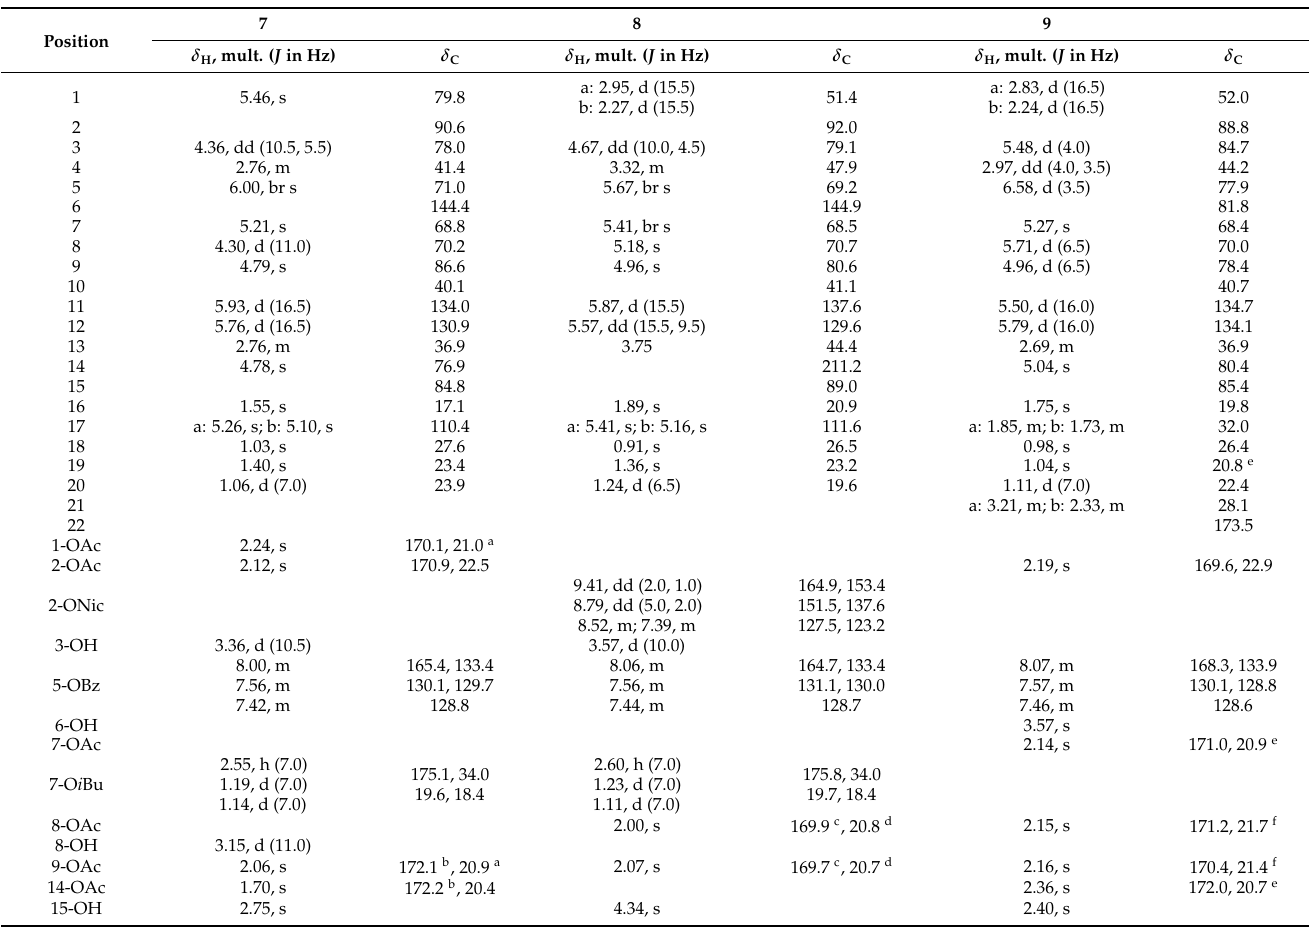
Table 3. 1 H (500 MHz) and 13 C (125 MHz) NMR data of compounds 7 – 9 in CDCl 3 ( δ in